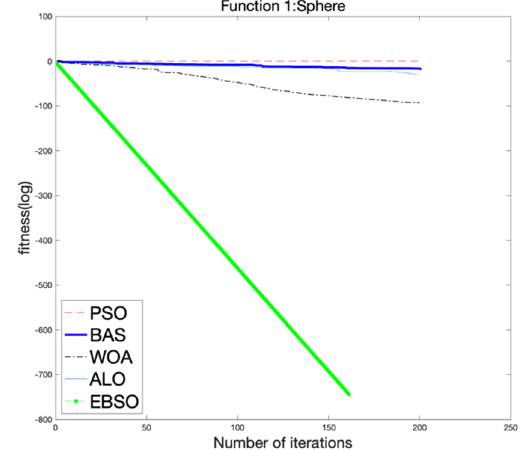
Figure 7. Iterative convergence graph.